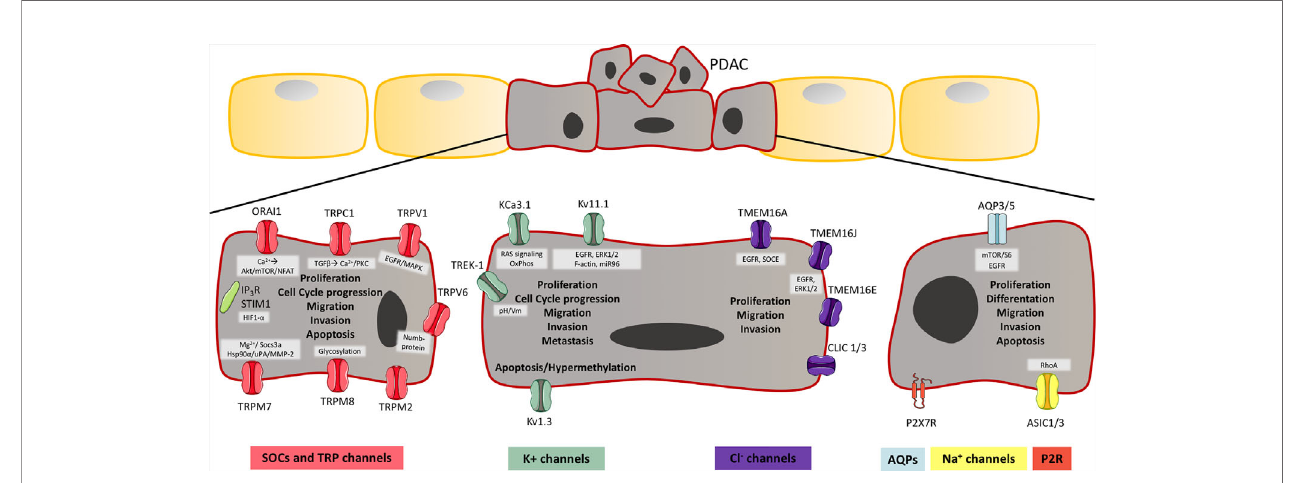
FIGURE 2 | Ion channels in pancreatic ductal adenocarcinoma (PDAC). Illustration of ion channels, which have been shown to have a role in hallmarks of cancer, thereby PDAC development and progression. As cancer cells lose their polarity, the localization of the channels is unknown, and on the illustration, it should be considered that the channels have no particular localization. The aberrant expression in PDAC cells, are shown for; Store-operated channels (SOCs) and transient receptor potential (TRP) channels, K + channels, Cl - channels, aquaporins (AQP), Na + channels and P2X7R. These channels are known to be involved in PDAC development and progression through proliferation, cell cycle progression, differentiation, migration, invasion, metastasis, and apoptosis. The known pathways and mechanism, which have been shown to be involved in these processes are shown in a grey box next to the channel and are mentioned in Table 2 . The channels shown to be expressed in PDAC, but where the role is unknown are also shown in Table 2 .